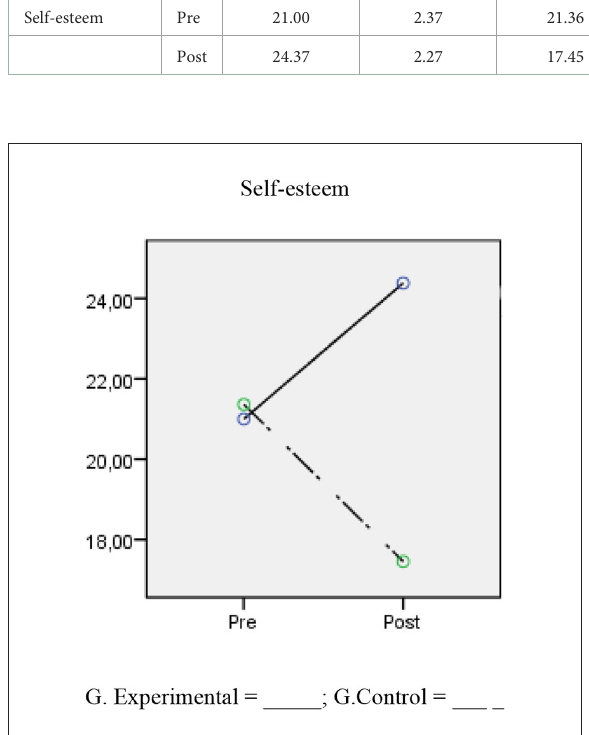
FIGURE3 Change in self-esteem scores between experimental and control